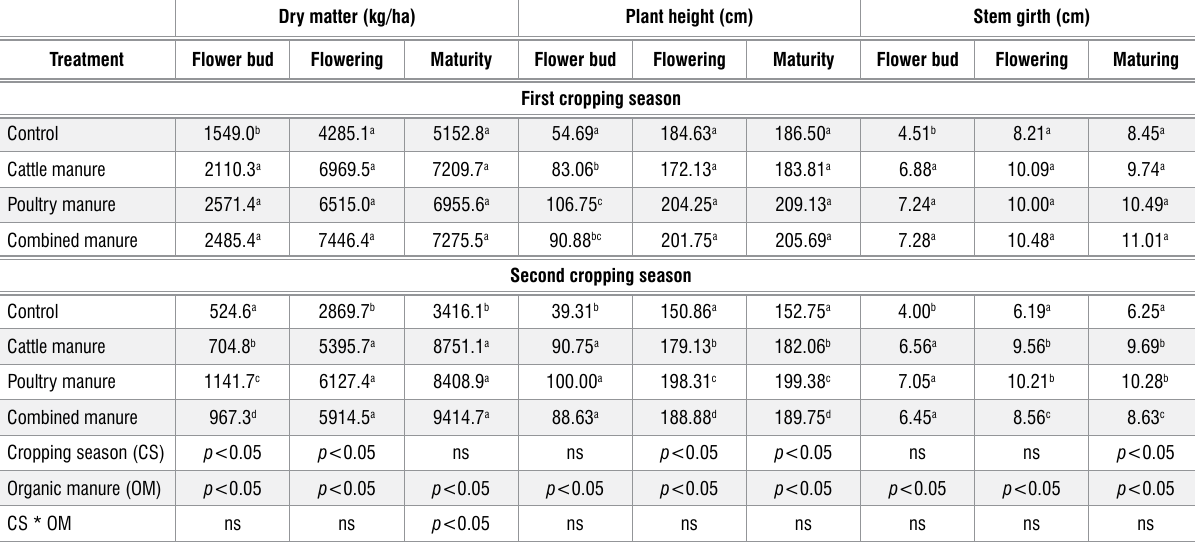
Table 6: Effect of organic manure on dry matter, plant height and stem girth determination